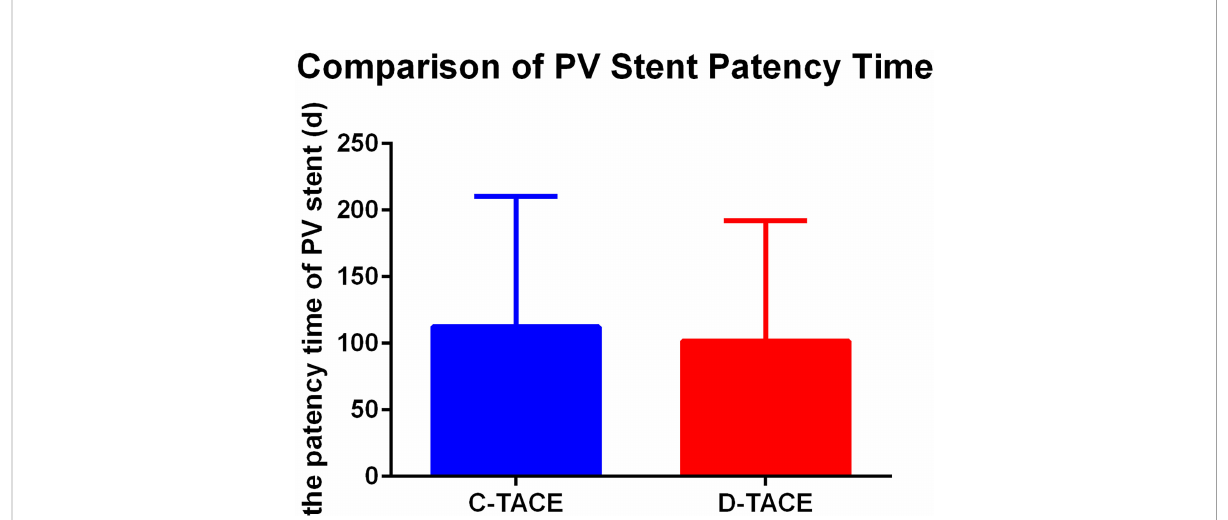
FIGURE 4 Comparison of PV stent patency time. The stent patency times of the two groups were 112.3 ± 98.2 days in the C-TACE group and 101.7 ± 90.4 days in the D-TACE group, and there was no signi fi cant difference between the groups (U = 84, p>